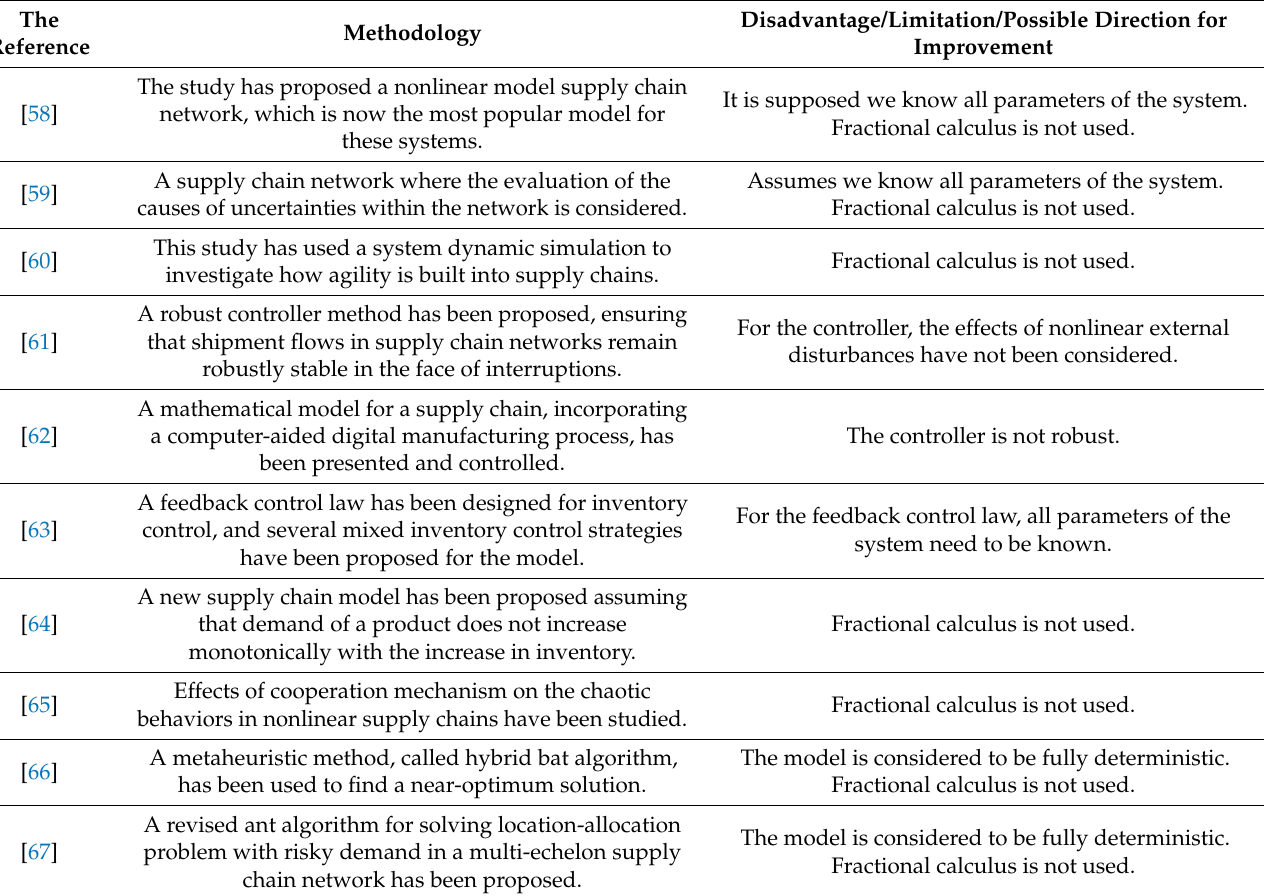
Table 1. Some important studies on nonlinear supply